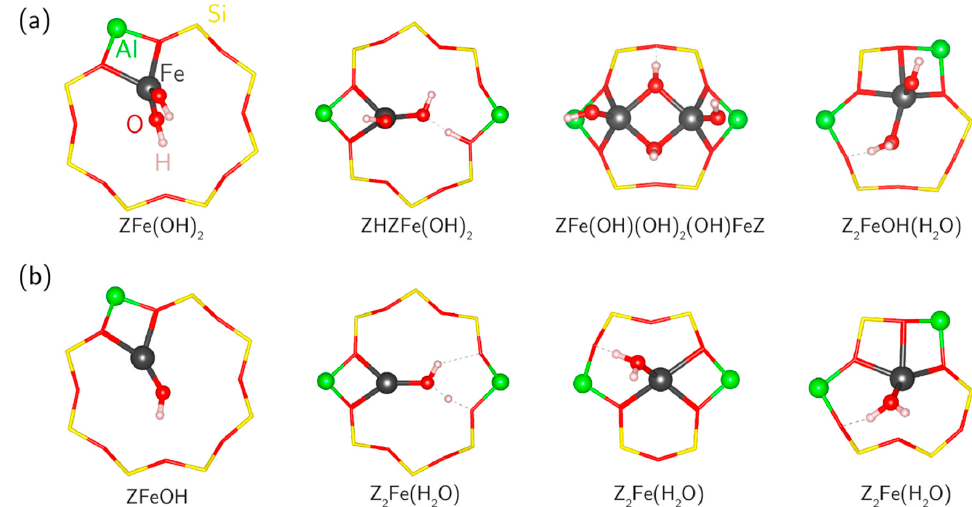
Figure 9. Lowest-relative-energy formal ( a ) Fe 3+ and ( b ) Fe 2+ species optimized via the Perdew-Becke-Erzenhof (PBE) functional. For ease of visualization, only framework atoms of the nearest 6- or 8MR are shown. Reprinted with permission from [35]. Copyright © 2018 American Chemical Society.